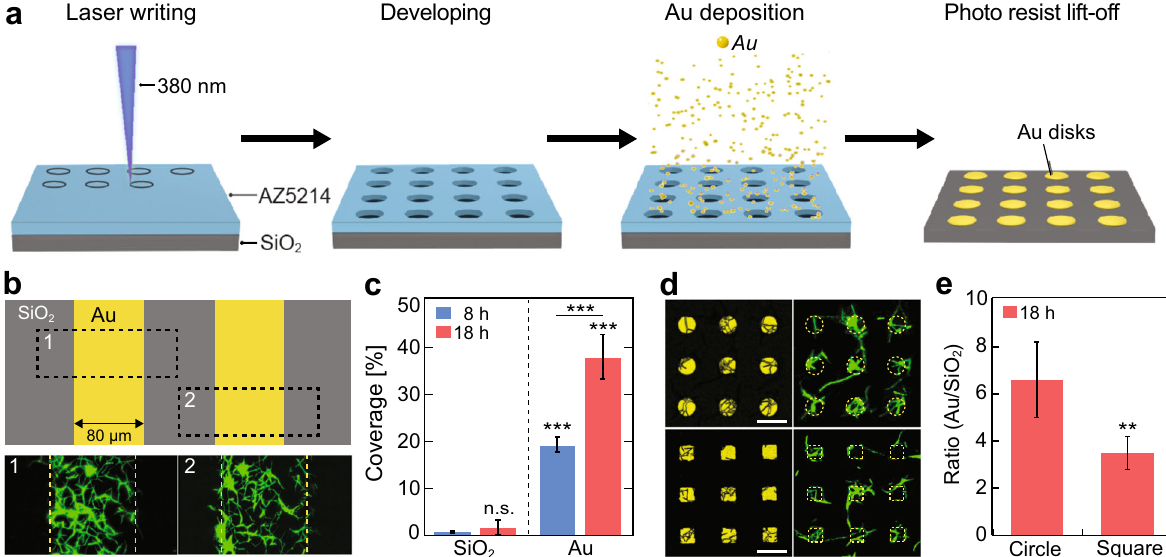
Fig. 1 Fabrication of Au micropatterns and substrate-selective bacterial adhesion. a Stepwise schematic representation of Au pattern fabrication on SiO 2 substrate. b Representative fl uorescence images of selective bacterial adhesion to Au line patterns and SiO 2 substrate after 18 h growth. c Bacteria coverage (mean ± s.d.) on SiO 2 and Au line patterns after 8 and 18 h of growth. d Representative fl uorescence and corresponding laser re fl ection images of bacterial adhesion on circular-shaped (11 µm diameter) and square-shaped (11 µm edge length) Au arrays, separated by 14 µm, after 18 h growth; scale bar denotes 20 µm. e Ratio (mean ± s.d.) of Au to SiO 2 bacterial coverage on circular and square-shaped Au arrays after 18 h growth. Asterisks indicate statistical signi fi cance (** p < 0.01; *** p < 0.001; n.s. = non-signi fi cant) resulting from two-tailed, unpaired t -tests. See also Supplementary Fig.